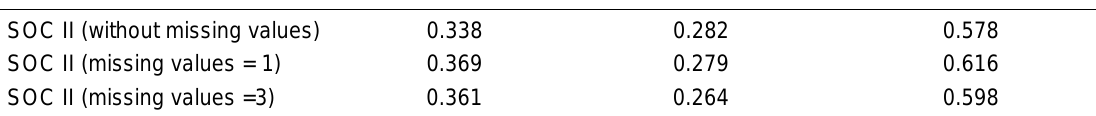
Sensitivity Analysis: Person Correlations Between SOC II (with Different Coding of the Missing Variables) and Health (all p <